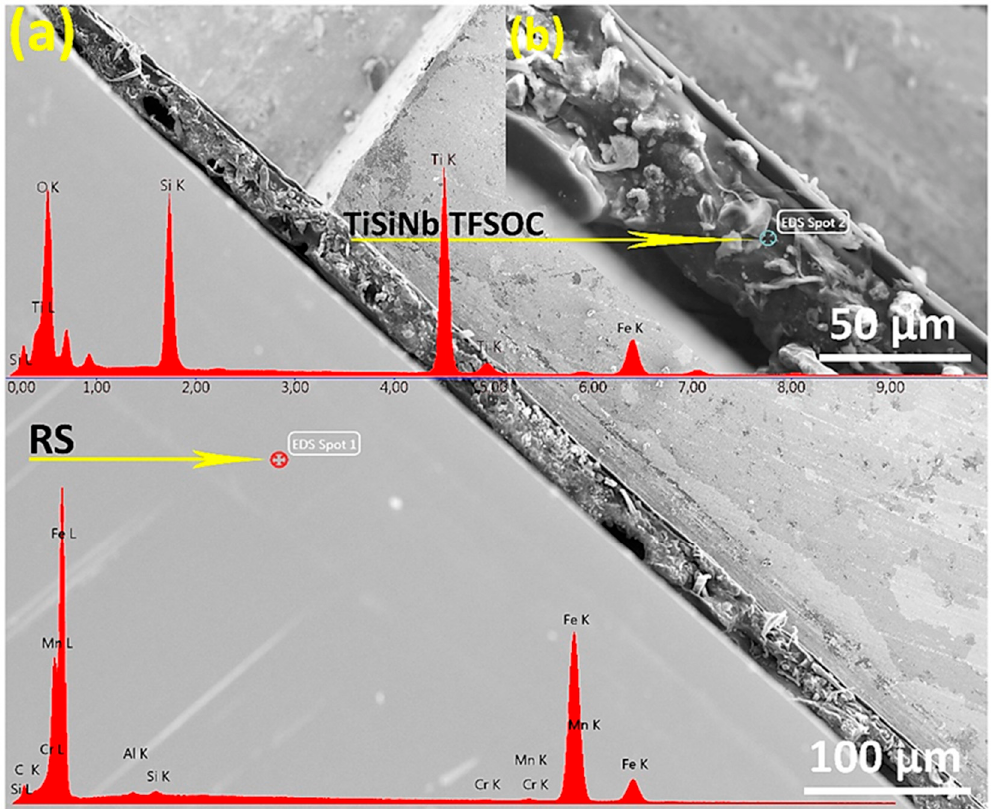
Figure5. SEMmicrograph( a )andaninsertreferredas( b )withEDSanalysisofthepolishedcross-section Figure 5. SEM micrograph ( a ) and an insert referred as ( b ) with EDS analysis of the polished cross- of TiSiNb 0.02 TFSOC annealed at 700 ◦ C in N 2 section of TiSiNb 0.02 TFSOC annealed at 700 °C in N 2 atmosphere.